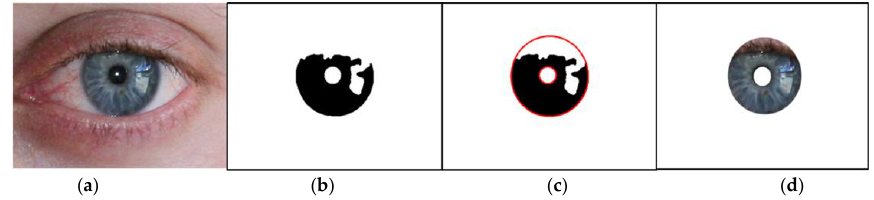
Figure 3. Detection of pupil and iris boundaries. ( a ) Original image; ( b ) binary mask image provided by the NICE.II training dataset; ( c ) results of pupil and iris boundary detection; ( d ) the iris region used in the research.